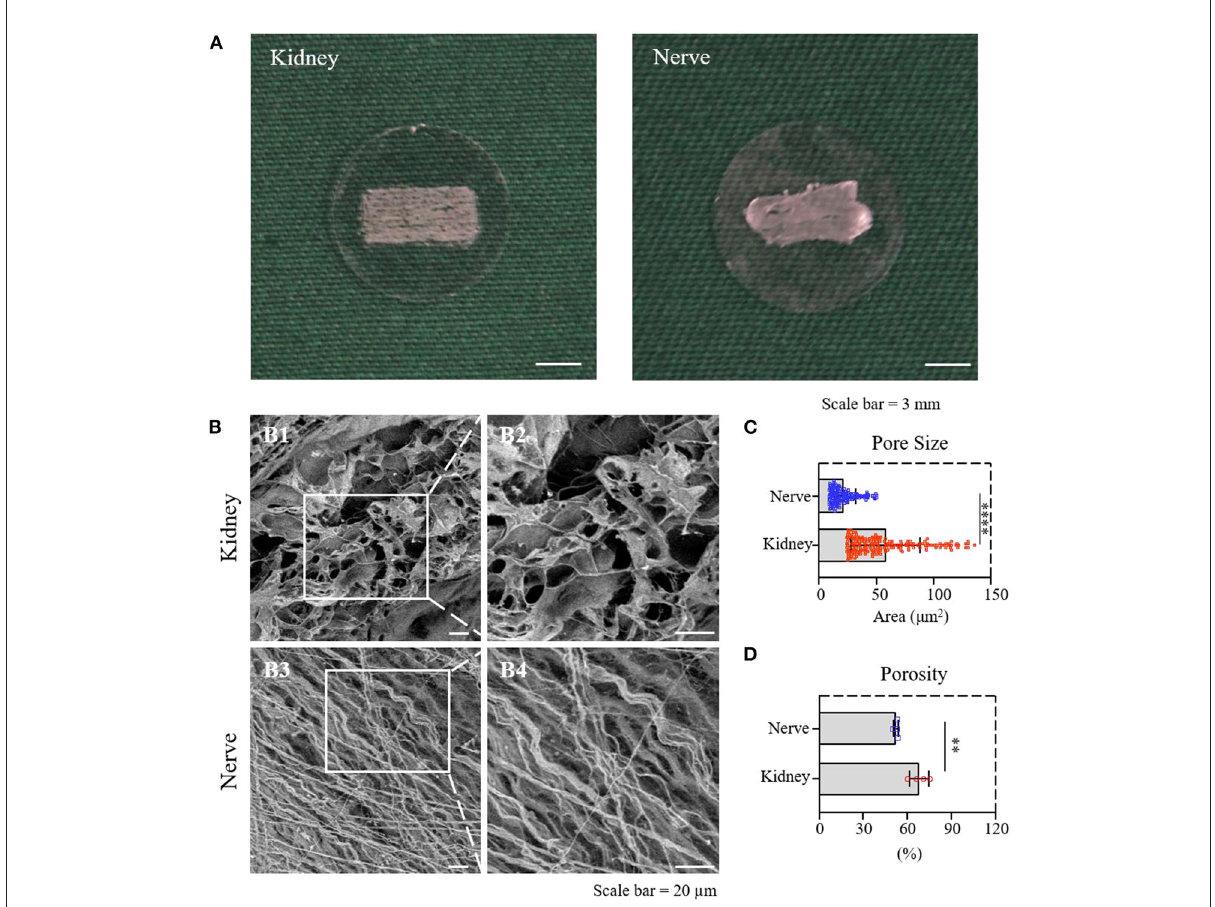
FIGURE2 Material characterization of dK and dN; (A) The decellularized frozen-tissue species on the cell slides; (B) SEM images showing the three-dimensional microarchitectures of decellularized kidney and nerve; (C) statistical result of the pore area of decellularized kidney and nerve; (D) statistical result of the porosity of decellularized kidney and nerve. ** P ≤ 0.01 and **** P ≤ 0.0001.